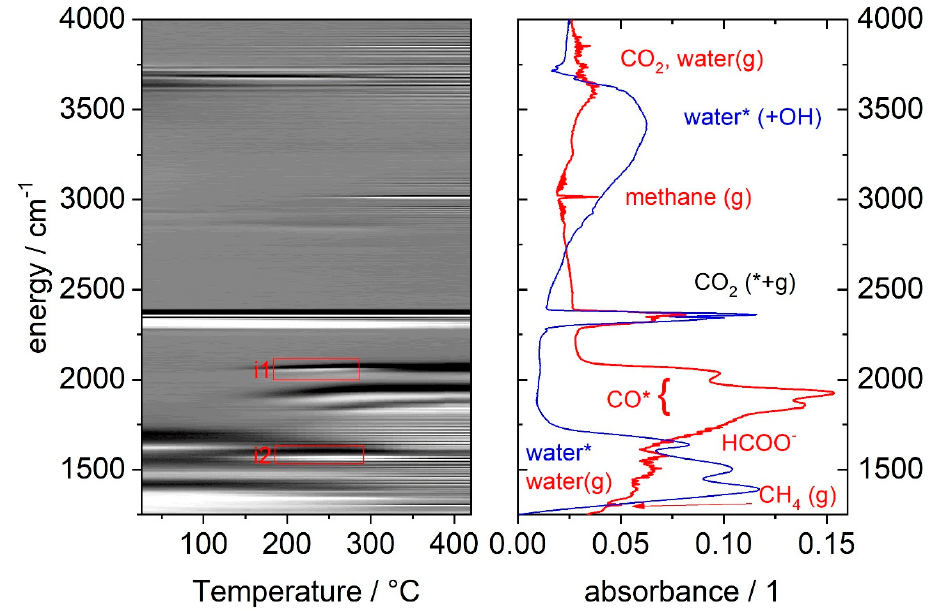
Figure 1. Diffusive reflectance infrared Fourier transform spectroscopy (DRIFTS) spectra of Ni on alumina/silica under methanation conditions between 50 and 400 °C. A difficulty of DRIFTS is the varying background with temperature. To emphasize the changes, the spectra were differentiated and plotted as a 2D greyscale image thereby suppressing the broad background. The right panel shows the original starting and final spectra at 50 and 400° C as blue and red curves, respectively. Most obvious adsorbates (*) and gases are assigned, note the change in the intermediates i1 and i2.